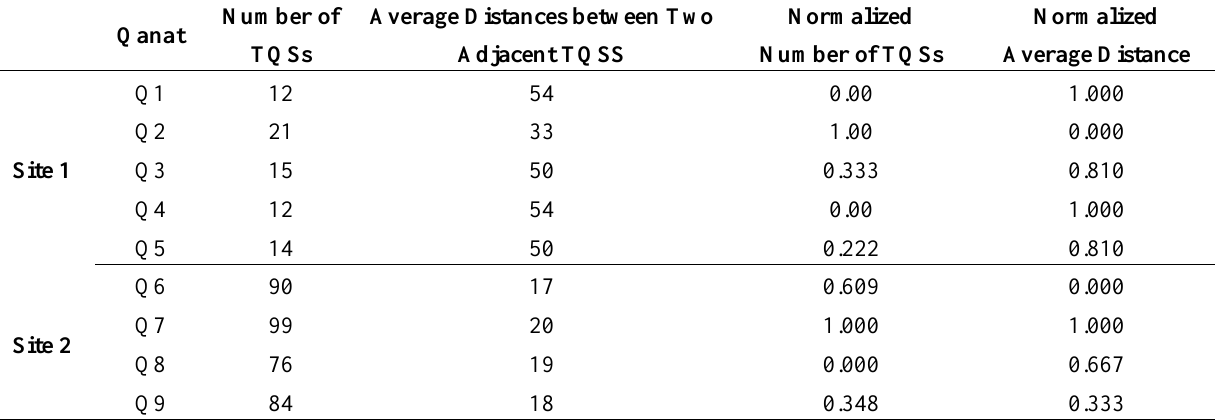
Table 2. TQSs statistics for